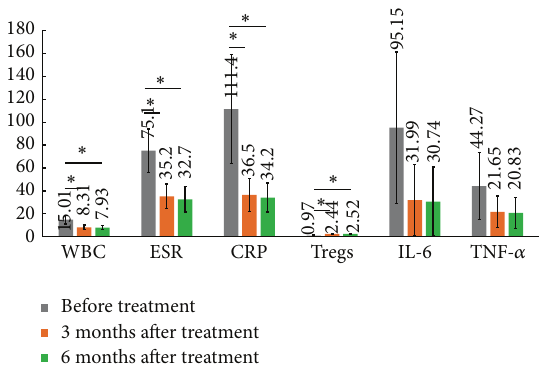
Figure 4: Laboratory measurement before/after UC-MSC treat- ment in JIA patients. To test the effect of MSC treatment on JIA patients, two-time measurements were done at three months after the first MSC infusion (orange column) and at three months after the second infusion (green column). Values such as WBC, ESR, CRP, Tregs, IL-6, and TNF- 𝛼 were analyzed and differences were compared with the values obtained before the MSC infusion (grey column). WBC, ESR, and CRP showed significant decreases, while Tregsshowedasignificantincrease.TheexpressionofIL-6andTNF- 𝛼 was declined at three months after the first and second UC-MSC